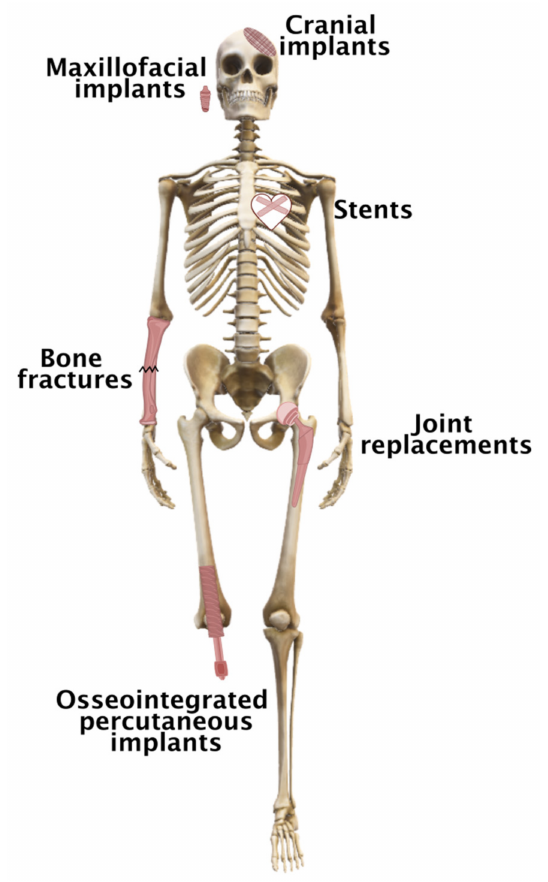
Figure 1. Some examples of metal-based implants used in the human